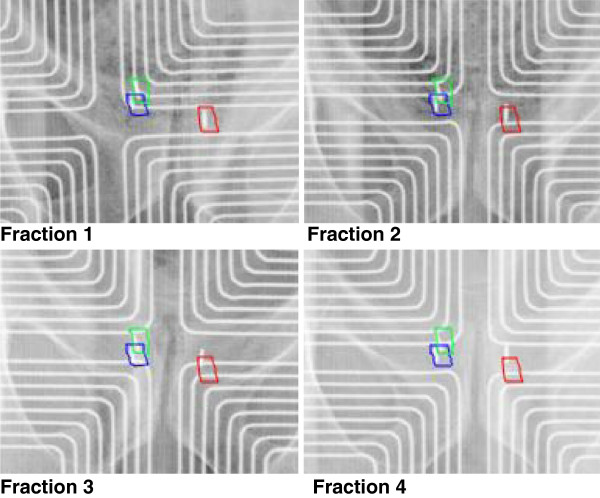
Calypso transponder shifted position over the course of treatment. The grid-like patterns in each image are the Calypso antenna, whose location relative to the patient is somewhat arbitrary for each fraction.